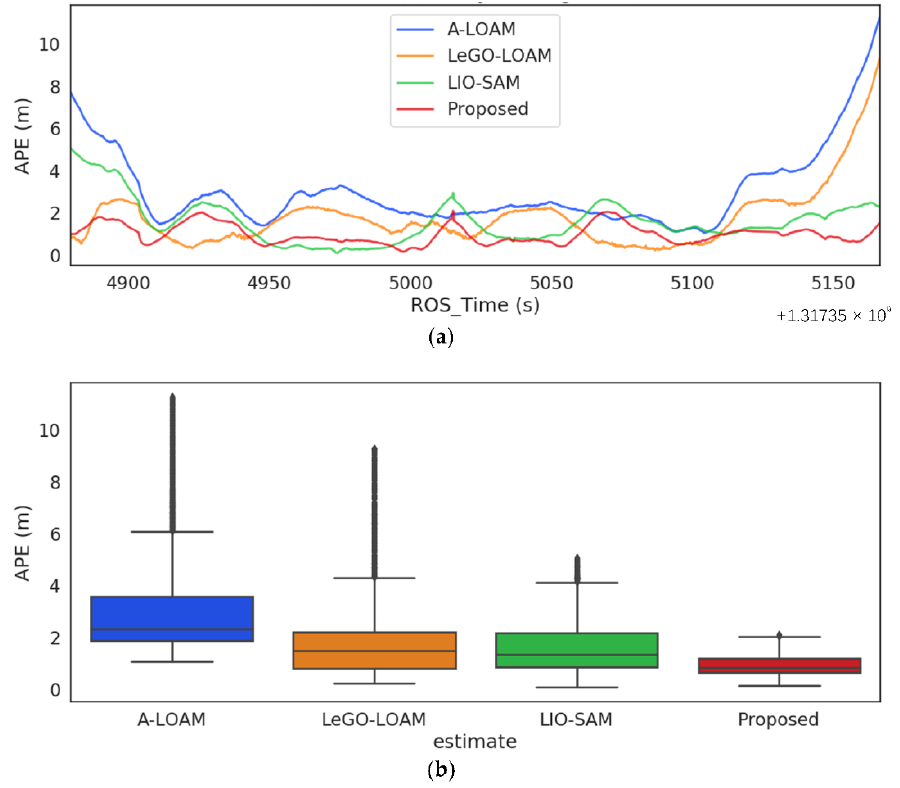
Figure 11. Comparison of the positioning error of each algorithm. ( a ) APE fitting curve. ( b ) The box diagram of APE.